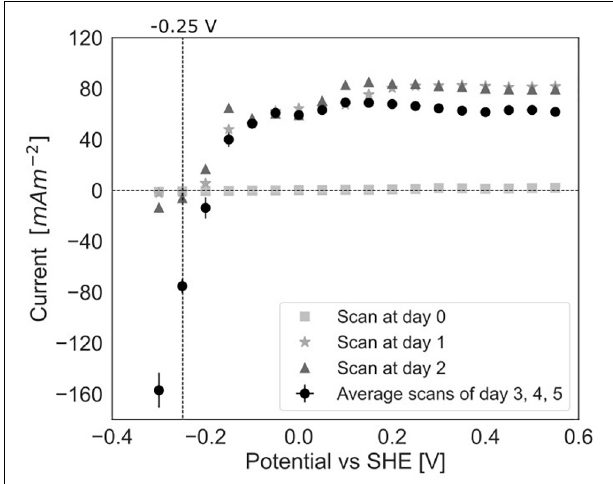
FIGURE 6 | Polarization curves in experiment C at day 0, after 1 day, after 2 days of incubation in the BES and an average of the curves after 3, 4, and 5 days (error bars show standard deviation, n =